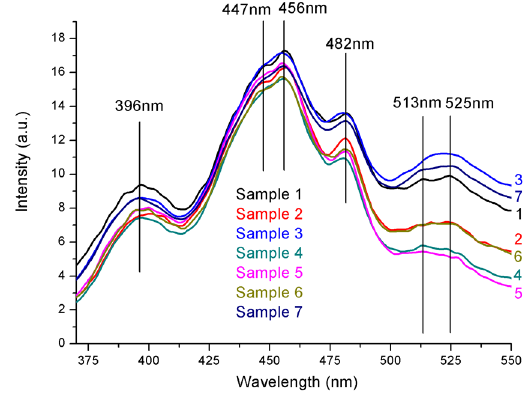
Figure 8. The PL spectra for ZnO obtained in ionic liquids media.